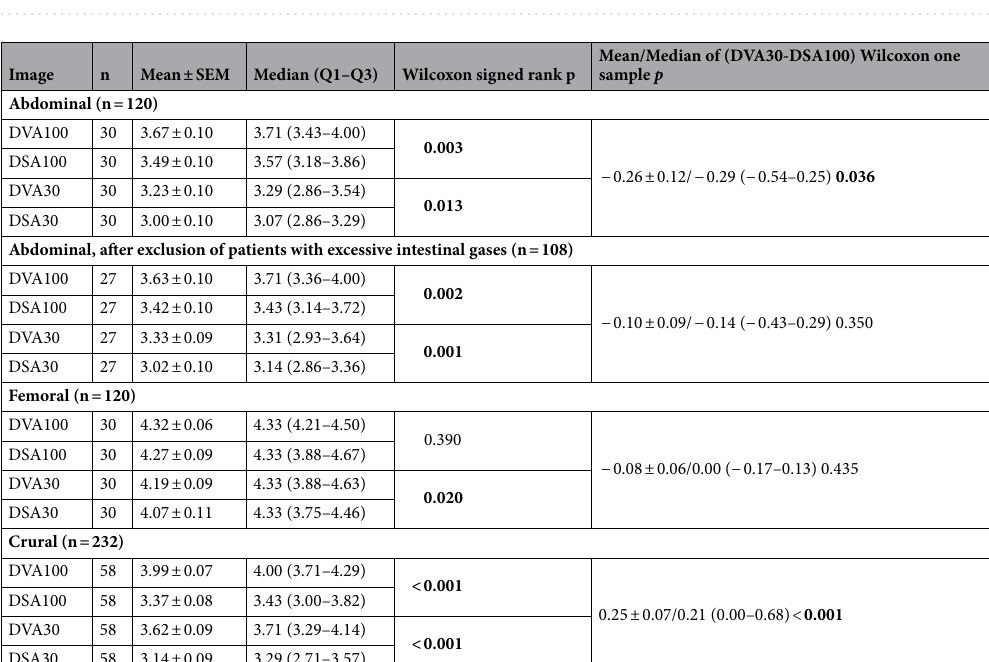
Figure 2. Comparison of the CNR values in three anatomical regions. The box and whisker plots show the median (line), interquartile range (box) and internal fences (whiskers) of CNR values in each group. The paired and unpaired data sets were analysed by the Wilcoxon signed rank test (*** p < 0.001) and the Mann Whitney U test (+++ p < 0.001), respectively. DSA: Digital Subtraction Angiography; DVA: Digital Variance Angiography. The index shows the applied protocol, 100: normal dose (1.2 µGy/frame), 30: low-dose (0.36 µGy/frame).